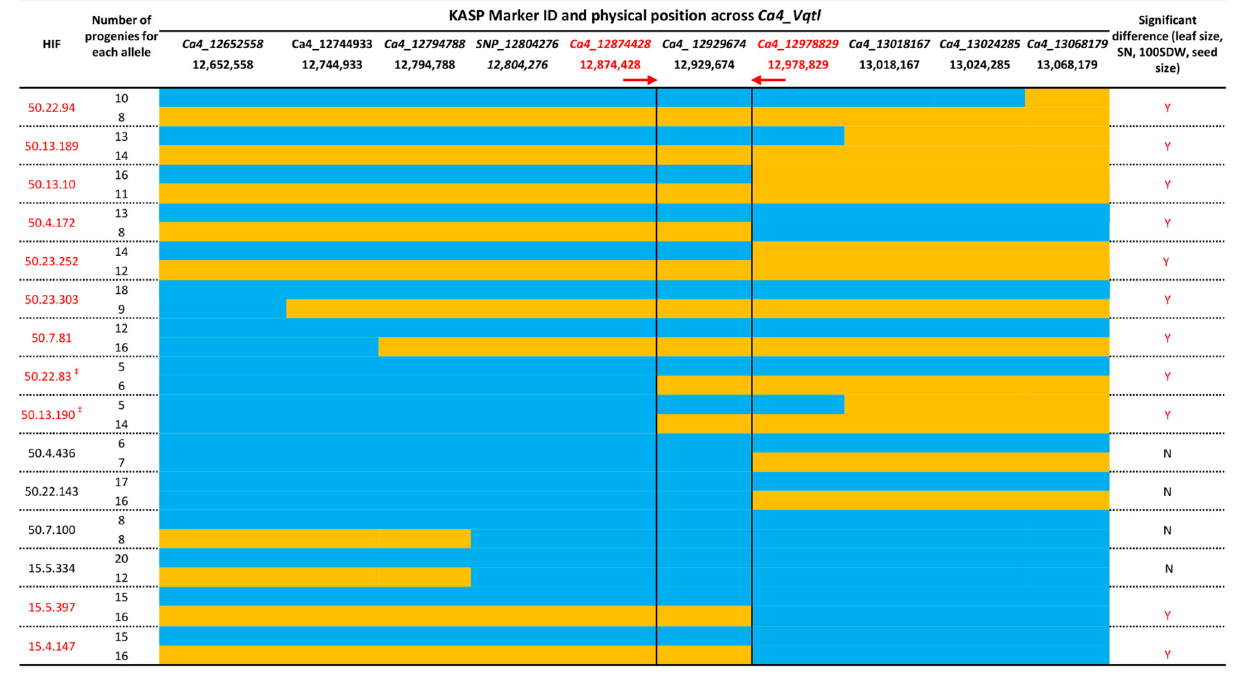
FIGURE 3 | Fine-mapping analysis of Ca4_Vqtl in Rupali/Genesis836 recombinant families. Fifteen HIFs with recombination within Ca4_Vqtl were phenotyped in greenhouse conditions in 2020 and 2021. Ten Kompetitive Allele-Specific PCR (KASP)-single-nucleotide polymorphism (SNP) markers were used to genotype and identify recombinant breakpoints. Orange color indicates Rupali (R) allele, while blue color indicates Genesis836 (G) allele. Red text highlights HIFs where significant differences were observed between allelic classes for leaf size, seed number (SN), average weight of 100 seed weight (100SDW), and seed size by Student’s t -test ( P < 0.05). Red arrows show the reduced interval between markers (in red) Ca4_12874428 and Ca4_12978829 (104.4 kb). ( ‡ ) Indicate lines phenotyped in 2021 under similar growing condition to 2020. The phenotyping data used for fine mapping is presented in Supplementary Table 2 .